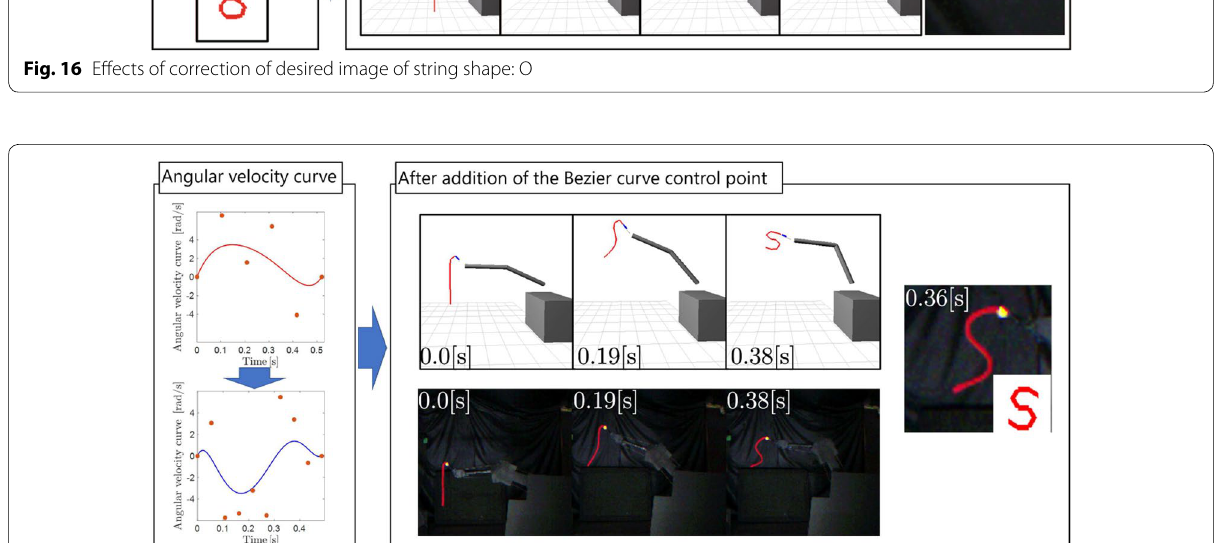
Fig. 17 Effect of increasing control points in Bezier curve for joint velocity (Desired images of string shape: S)